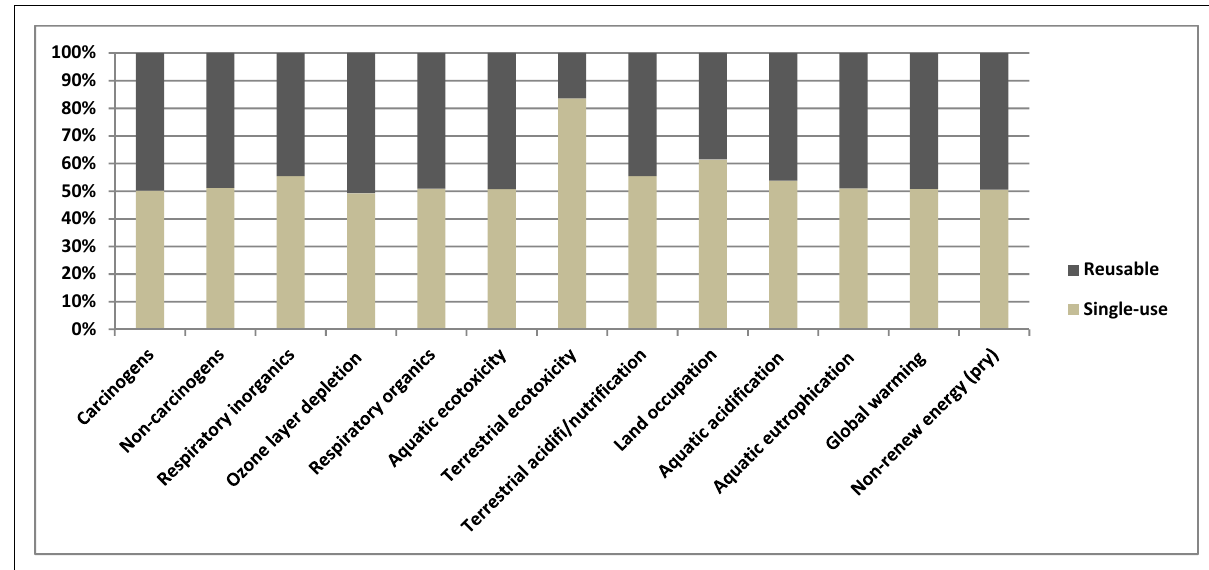
Figure 3: Equalisation of impacts for a single-use PET bottle at mass ratio of